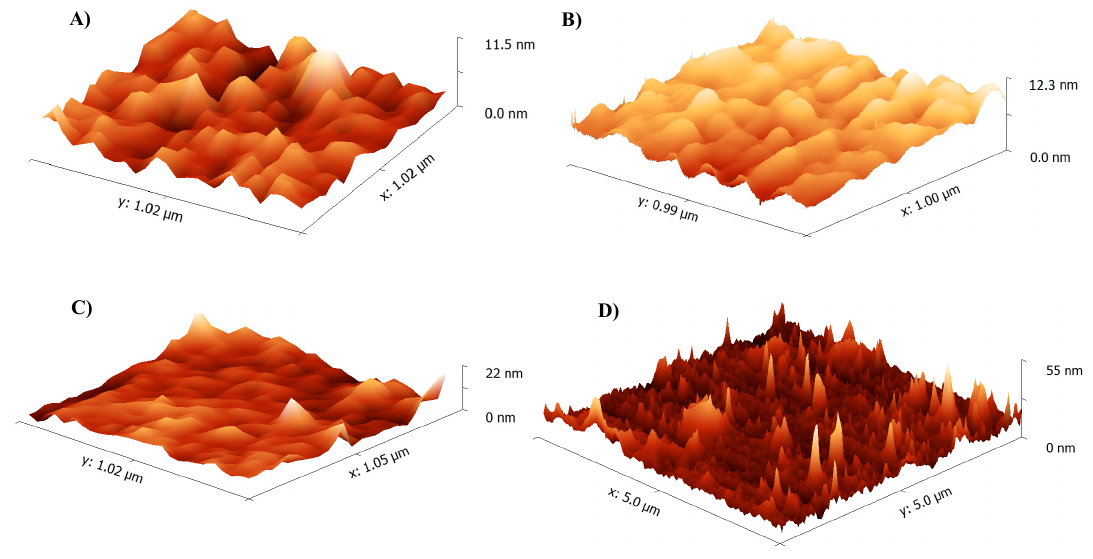
Figure 4. AFM analysis of bare ( A ), MUDA-coated ( B ) and antibody-immobilized ( C , D ) sensor surfaces.